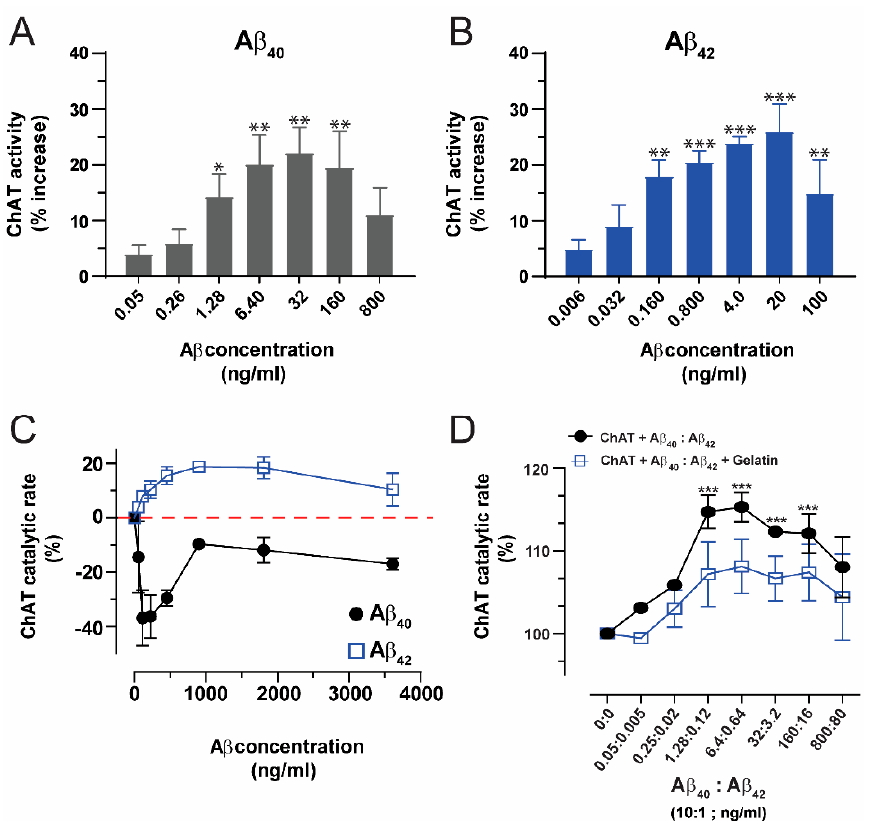
Figure 1. Soluble A β peptides specifically and allosterically activate ChAT at physiological concen- trations via direct interaction (adapted and reproduced from Kumar et al., [26], under the terms of the CC BY license). ChAT was incubated with A β peptides at physiological concentration ranges and changes in its activity were monitored using the kinetic ChAT fluorometric assay. ( A ) The per- cent changes in the rate of ChAT ( Δ RFU/hr) by A β 40 at the specified concentration range of 0 to 800 ng/mL ( B ) The corresponding percent of changes in ChAT activity by A β 42 , at the specified concen- tration range of 0 to 100 ng/mL. The activity of the control sample (ChAT with no A β ) was consid- ered as 100 % to calculate the percentage increase in ChAT activity in the presence of different A β concentrations. The values are shown as mean ± SEM of ≥ 3 independent experiments. ( C ) The effect of high concentrations (non-physiological range) of A β peptides on ChAT activity was also moni- tored. ChAT was incubated with different concentrations of A β 40 and A β 42 peptides, ranging from 0 to 3800 ng/mL in 96-well plates. The values are shown as mean ± SEM of two independent exper- iments. For A β 40 ( A ), the symbols * and ** represents p -values < 0.005 and < 0.0003, respectively, relative to the control (no A β 42 ). The comparisons are based on one-way ANOVA analysis and Fisher’s LSD post-hoc test. ( D ) Both A β 40 and A β 42 are present simultaneously in biological fluids at a 10:1 ratio. Therefore, we measured ChAT activity in the presence of various concentrations of mixtures of A β peptides to somewhat mimic the in vivo conditions. Graph shows the percent changes in ChAT activity at the specified A β mixture concentrations with or without gelatin (which mimics a high protein concentration microenvironment, as expected physiologically in biological fluids). The activity of the control sample (ChAT with no A β ) was considered 100%. The values are shown as mean ± SEM of ≥ 2 independent experiments. *** p < 0.0001, relative to the control (no A β ), based on one-way ANOVA analysis and Fisher’s LSD post-hoc test.